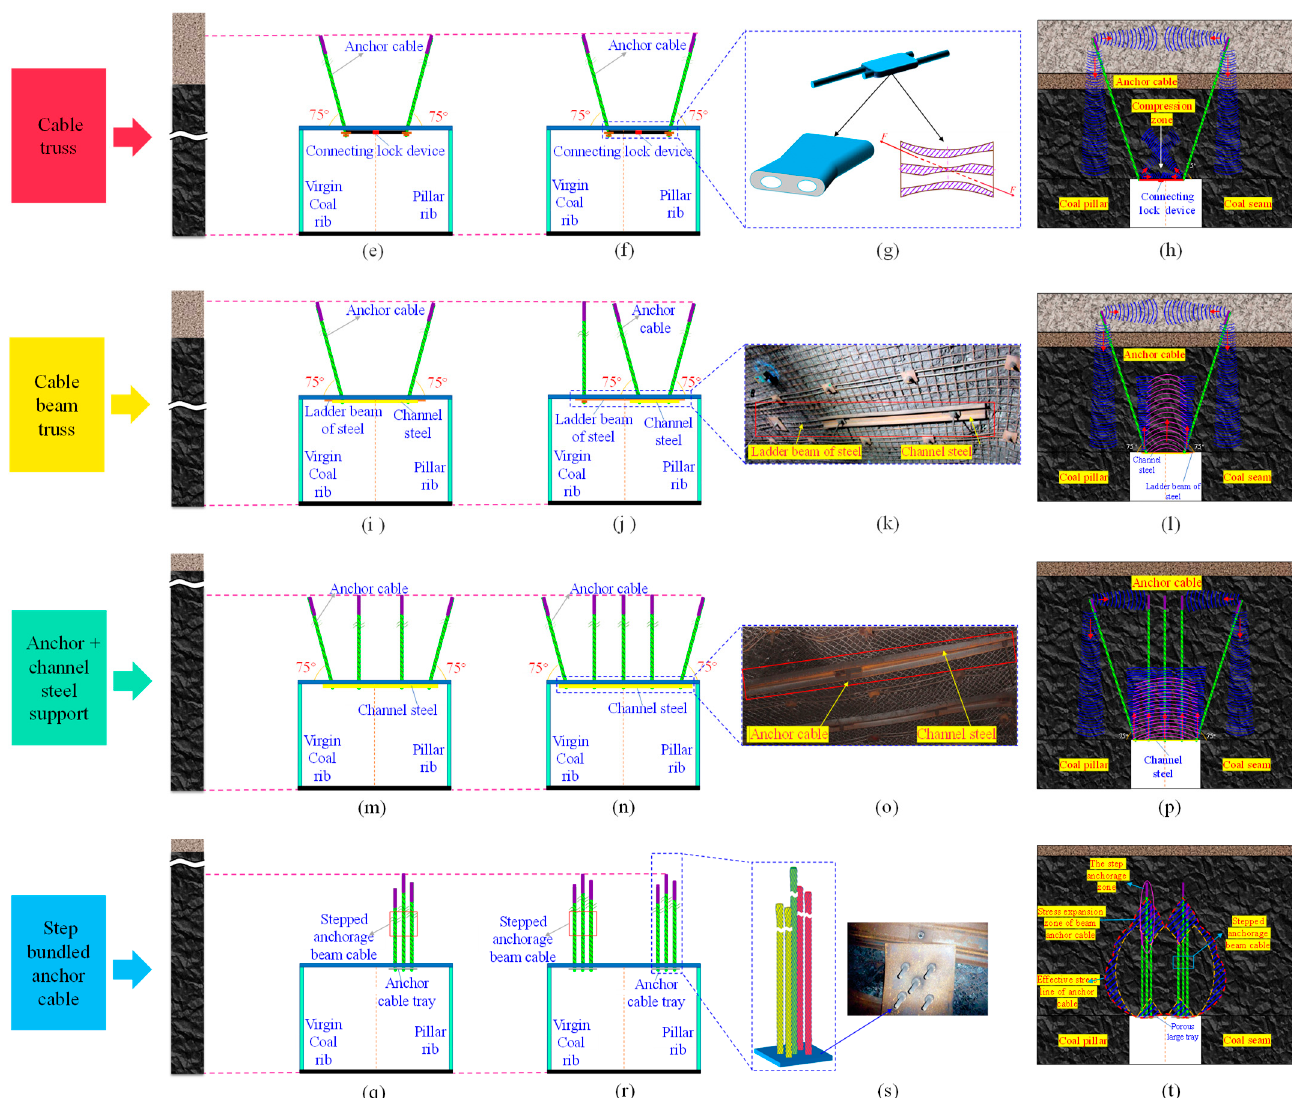
Figure 24. The roof support of gob-side entry driving: ( a ) single anchor cable support, ( b ) on-site support diagram, ( c ) anchor cable + W steel strip support, ( d ) on-site support diagram, ( e ) symmetric cable truss support, ( f ) asymmetric cable truss support, ( g ) connecting lock device, ( h ) supporting principle diagram, ( i ) asymmetric double anchor cable support, ( j ) cable truss + single anchor cable support, ( k ) on-site support diagram, ( l ) supporting principle diagram, ( m ) channel steel + four anchor cables support, ( n ) channel steel + five anchor cables support, ( o ) on-site support diagram, ( p ) supporting principle diagram, ( q ) single-step bundled anchor cable support, ( r ) step bundled anchor cable support, ( s ) stepped anchorage beam cable, and ( t ) supporting principle diagram.